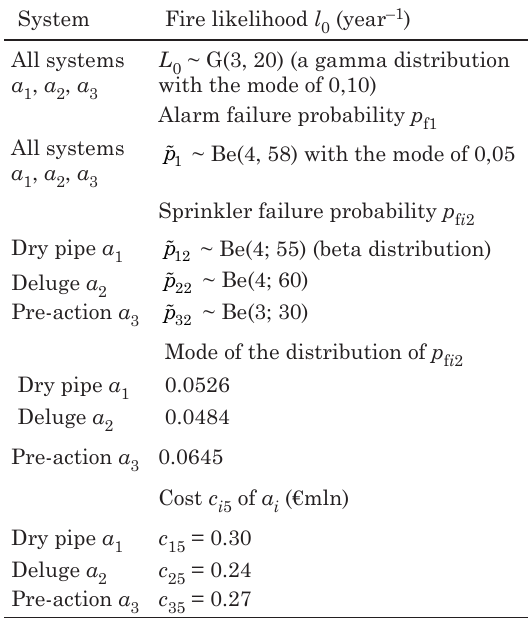
table 1. initial data used for the selection